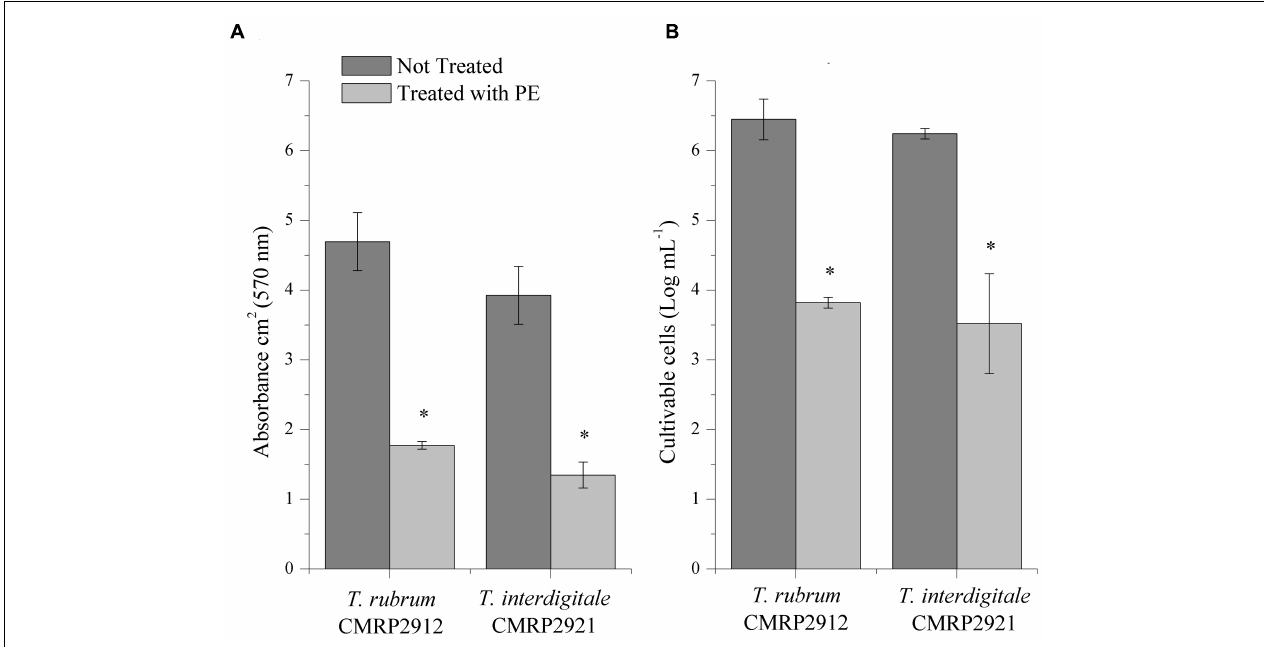
FIGURE 3 | In vitro biofilm inhibition by propolis extract (PE) measured through two methods: Crystal violet-staining biomass production (A) and Colony-Forming Units (B) of T. rubrum CMRP2912 and T. interdigitale CMRP2921 biofilms exposed to PE. ∗ p < 0.05 compared to untreated control group.